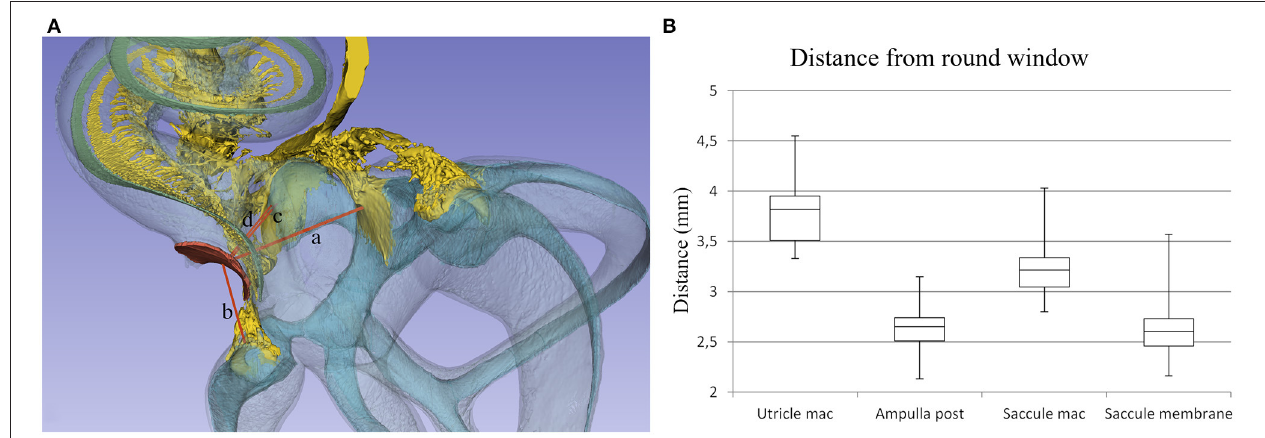
FIGURE 11 | (A) Distances from the (a) utricle macula, (b) posterior semicircular canal ampulla, (c) saccule macula, and (d) saccule membrane to the middle of the RW were assessed. (B) Box plot showing measurements in 22 temporal